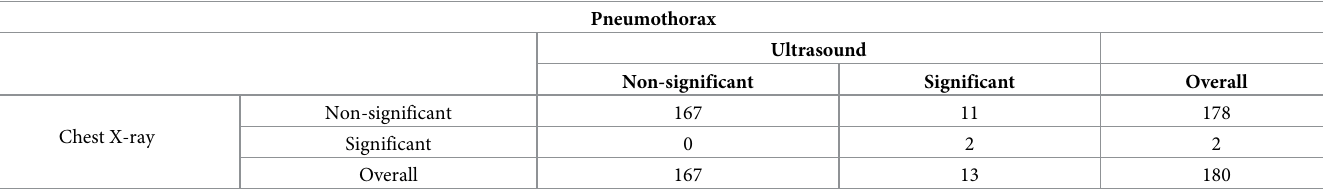
Table 2. PNX: Agreement between LU and CXR by clinically oriented method (scores 0, 1–2 = non-significant; 3–6 = significant).